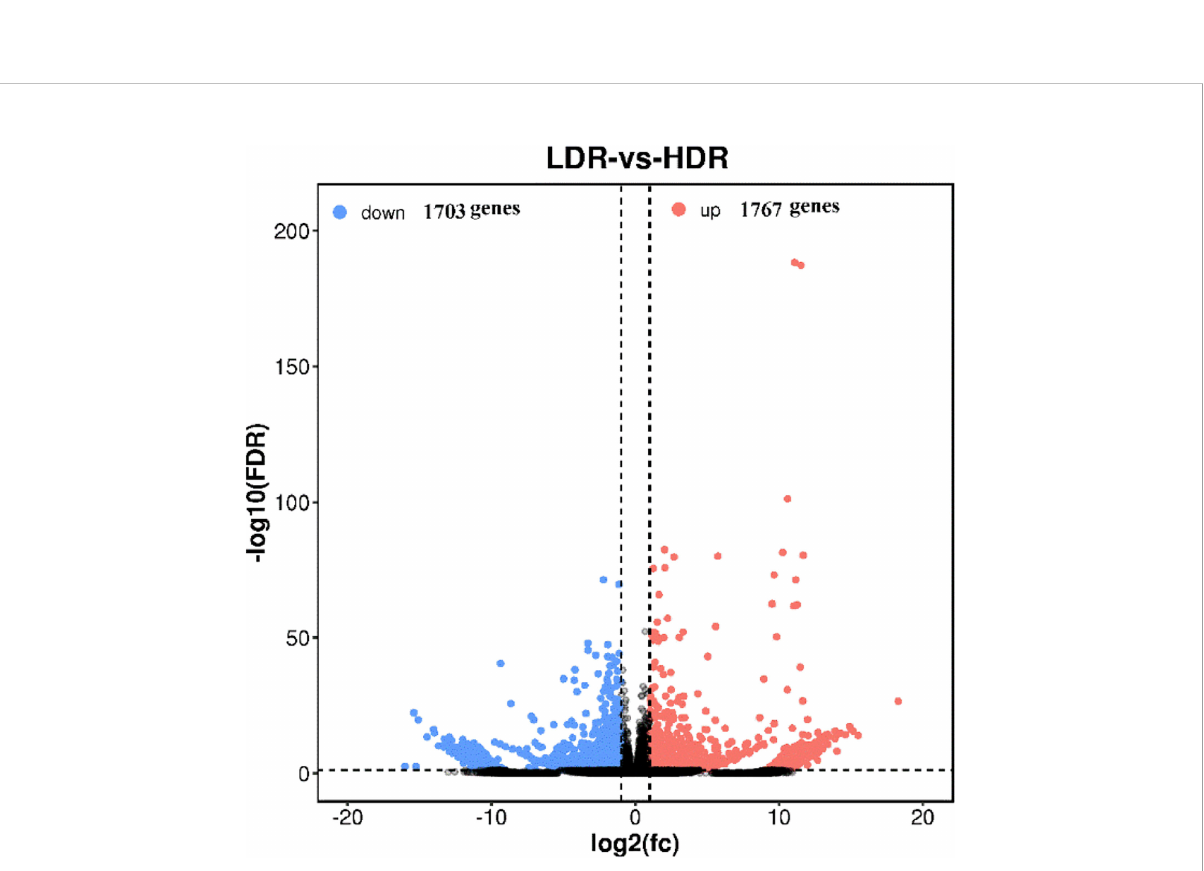
FIGURE 6 LDR vs HDR differentially expressed gene volcano plot The abscissa represents the logarithm of the difference between the two groups, and the ordinate represents the negative Log10 value of the FDR of the difference between the two groups. Blue dots indicate genes with down- regulated expression and red dots indicate genes with up-regulated